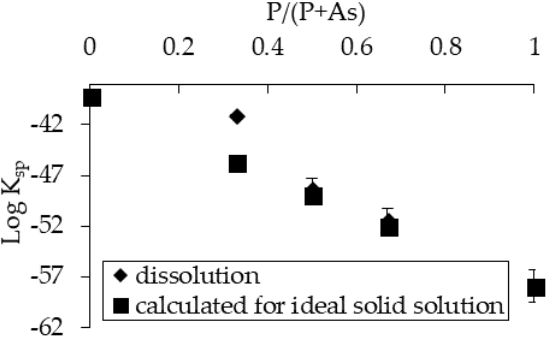
Figure 11. Calculated and experimentally determined ionic activity products (IAPs) of synthetic phases from the HAP–JBM series as a function of their chemical composition.